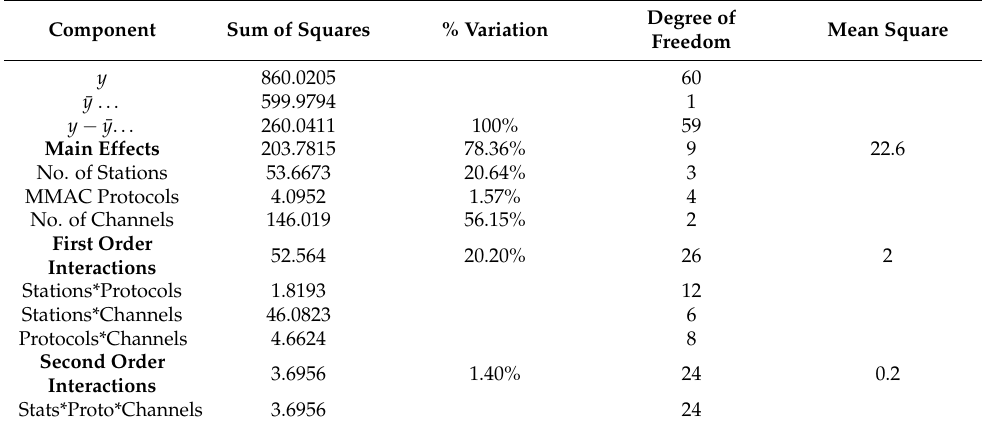
Table 6. ANOVA for normalized throughput.